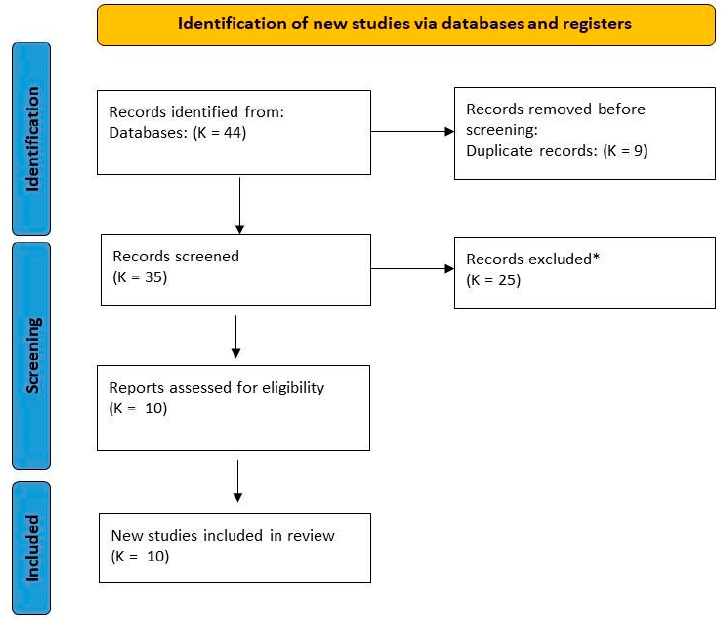
Figure 1. Flow diagram of the studies’ selection process. * excluded for not meeting the inclusion criteria.